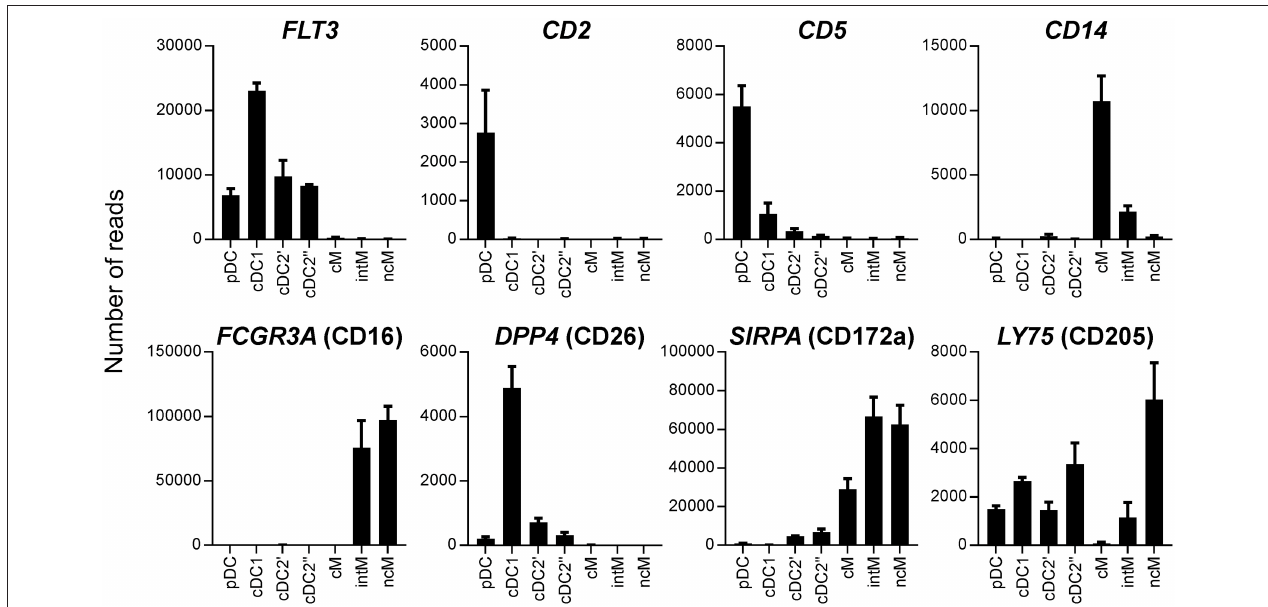
FIGURE 4 | Transcript levels for molecules previously analyzed by flow cytometry. High-throughput sequencing was performed on RNA isolated from sorted DC and monocyte subsets. Mean number of normalized reads and SD is shown for three animals.